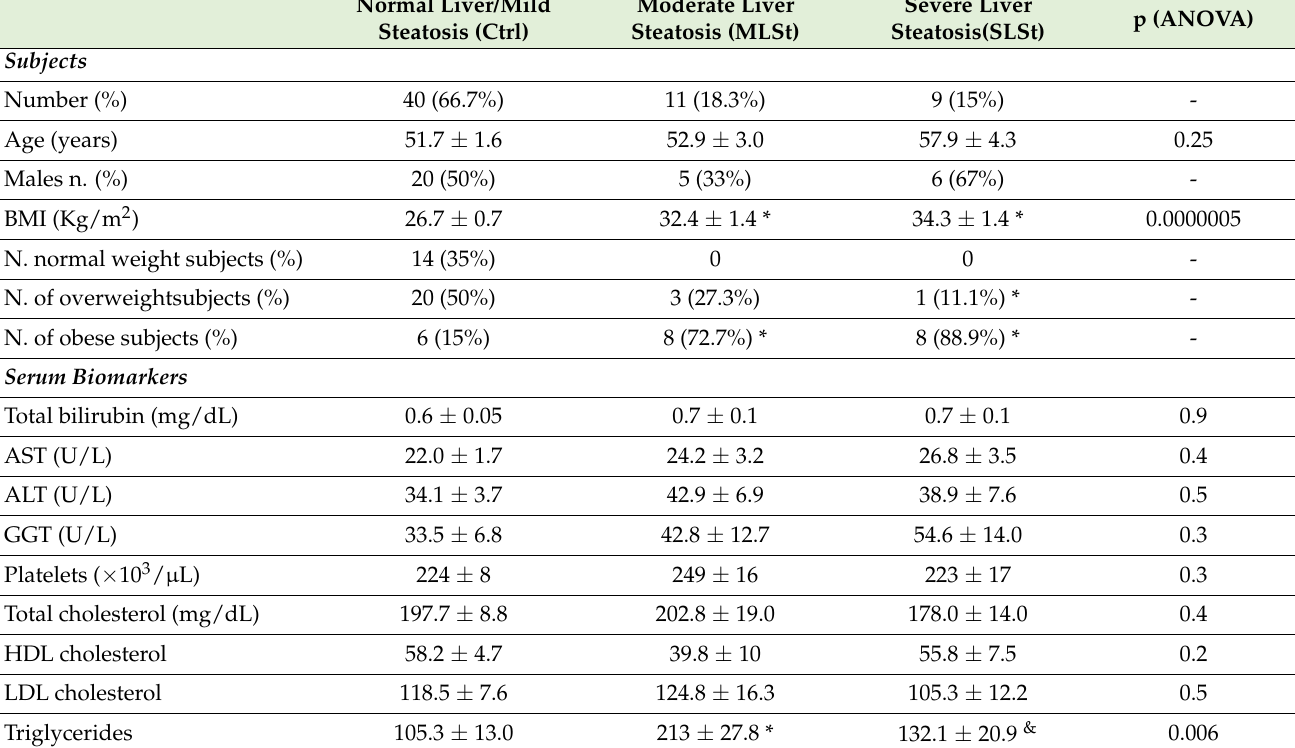
Table 1. General characteristics, liver stiffness and indices of liver fibrosis in a group of 60 adults selected according to the presence/extent of liver steatosis by USG. p value was assessed by ANOVA followed by Fisher’s LSD Multiple-Comparison test. * p < 0.05 vs. Ctrl; & p < 0.05 vs.